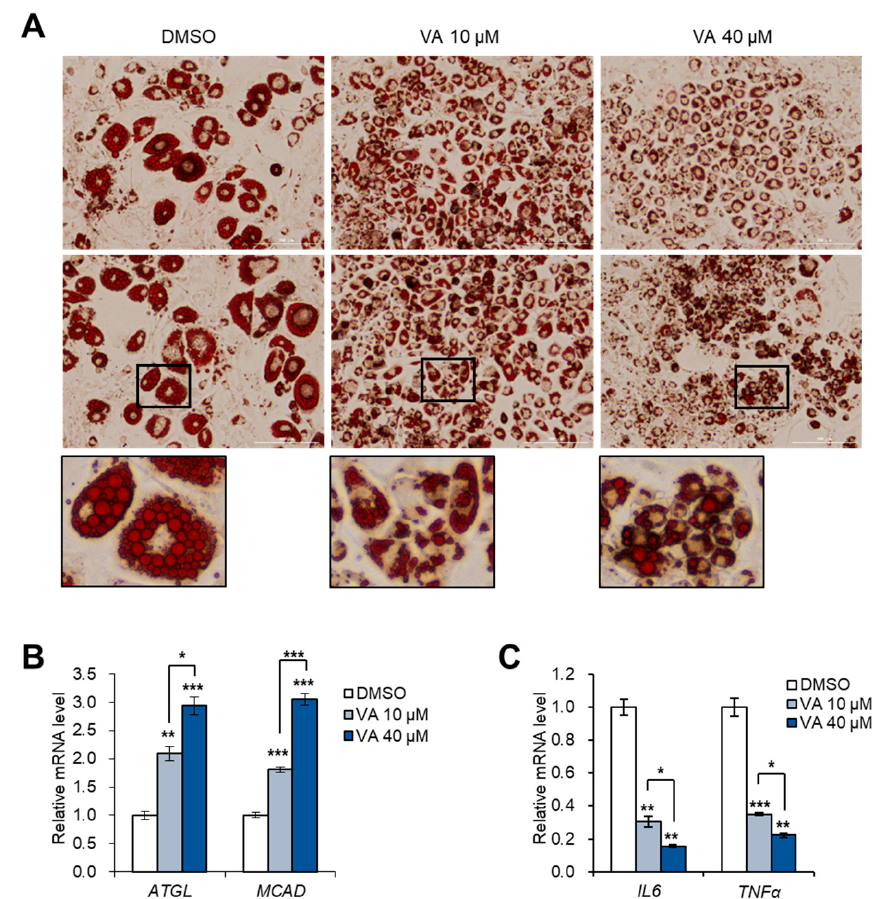
Figure 5. Vulpinic acid reduces hypertrophic adipocytes by promoting hyperplasia. ( A ) Oil-red-O staining of 3T3-L1 adipocytes incubated with vulpinic acid (10 or 40 µ M) during adipogenesis. Scale bar = 200 µ m (40X). ( B ) The mRNA levels of ATGL and MCAD genes in 3T3-L1 adipocytes incubated with vulpinic acid (10 or 40 µ M) during adipogenesis. ( C ) The mRNA levels of IL6 and TNF α genes in 3T3-L1 adipocytes incubated with vulpinic acid (10 or 40 µ M) during adipogenesis. Data represent means ± SEM for n = 3. * p < 0.05, ** p < 0.01, *** p < 0.001.